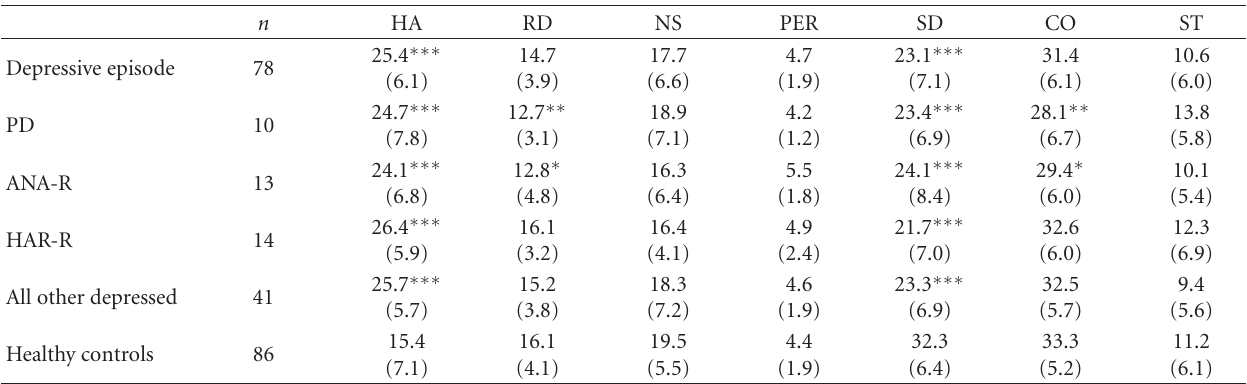
Table 1: Temperament and character (standard deviation between brackets) during the acute depressive episode of psychotic depression (PD), ANA-R depression, HAR-R depression, and all other depressed patients, as well as in healthy controls ( ∗∗∗ P < 0 . 001; ∗∗ P < 0 . 0071; ∗ P < 0 . 05: P values compared with